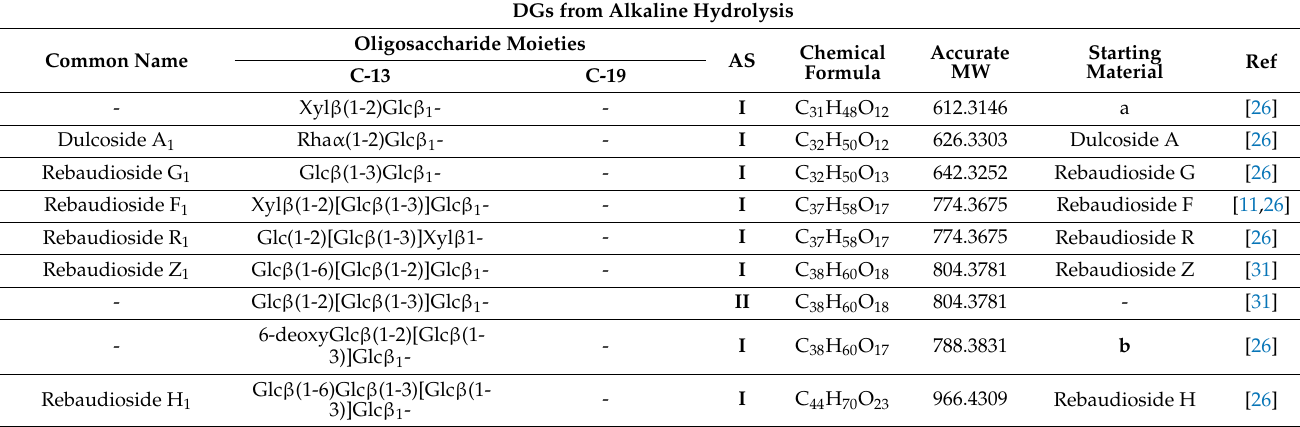
Figure 1. Aglycone cores reported from S. rebaudiana as natural forms, degradation products or forming part of a glycoside compound (R 1 and R 2 ). steviol ( I ); ent -atisene ( II ); isosteviol ( III ); endo steviol ( IV ); CH 3 and OH at C-16 ( V ); CHO at C-16 ( VI ); CH 2 OH at C-16 ( VII ); C-12 linkage ( VIII ); 15- α -hydroxy-rebaudioside M ( IX ). Table 1. Compounds reported as degradation products from natural diterpene glycosides by alkaline or acid conditions. a 13-[(2- O - β -D-xylopyranosyl - β -D-glucopyranosyl-)oxy] ent -kaur-16-en-19-oic acid β -D-glucopyranosyl ester; b 13-[(2- O -6-deoxy- β -D-glucopyranosyl-3- O - β -D-glucopyranosyl- β -D-glucopyranosyl)oxy] ent -kaur-16-en-19-oic acid β -D-glucopyranosyl ester.